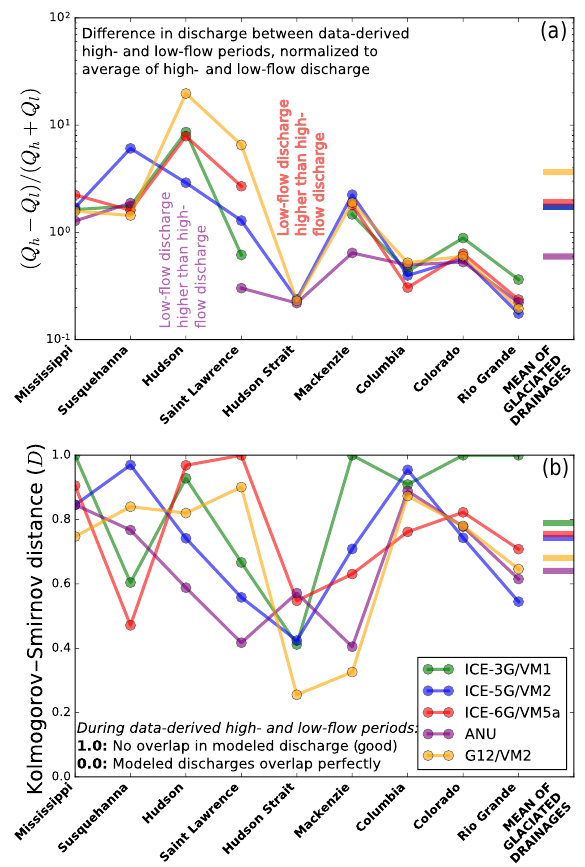
Figure 17. Computed discharges are classified as occurring at times of known high or low flow based on geologic record. Times of high flow in the geologic record are denoted by both light and dark gray in Figs. 11–16. (a) Normalized difference in the modeled dis- charge between geologically known high and low discharge times. The greatest mean normalized difference is seen in G12, the ice- physics-based model of Gregoire et al. (2012), and the least in the GIA-based model of Lambeck et al. (2002). (b) The Kolmogorov– Smirnov test measures the distance between one-dimensional dis- tributions; here I use it to compute a metric of difference between the computed discharge histograms for each river system during the generalized data-derived times of high and low discharge. A high distance value indicates a good match between the data and model. Here, the GIA-based ICE-3G and ICE-6G models perform the best, with poor matches only to Hudson Bay. The ice-physics-based G12 performs poorly, due in part to the too early demise of its Québec– Labrador dome, and the GIA-based ANU model performs the